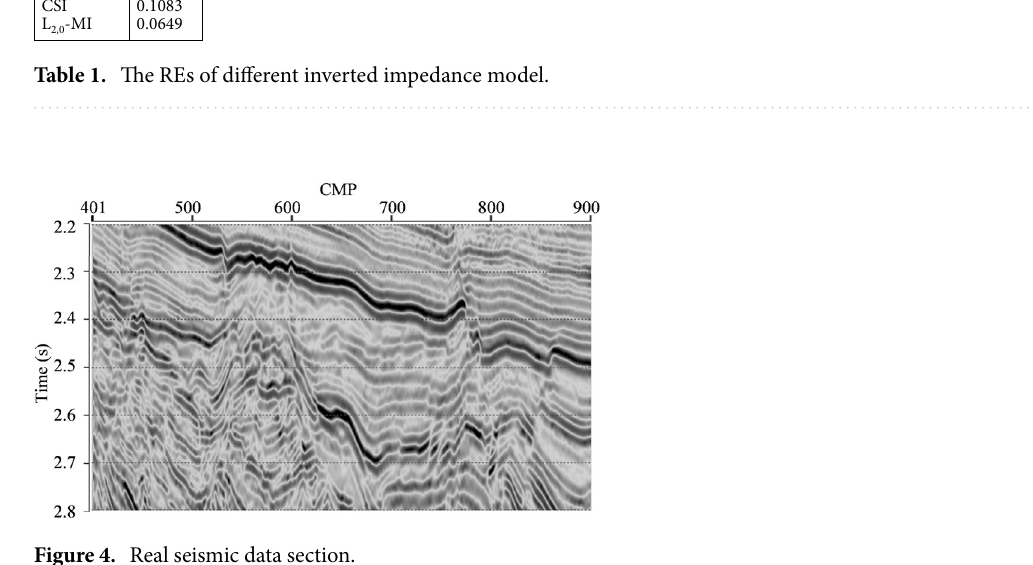
Figure 4. Real seismic data